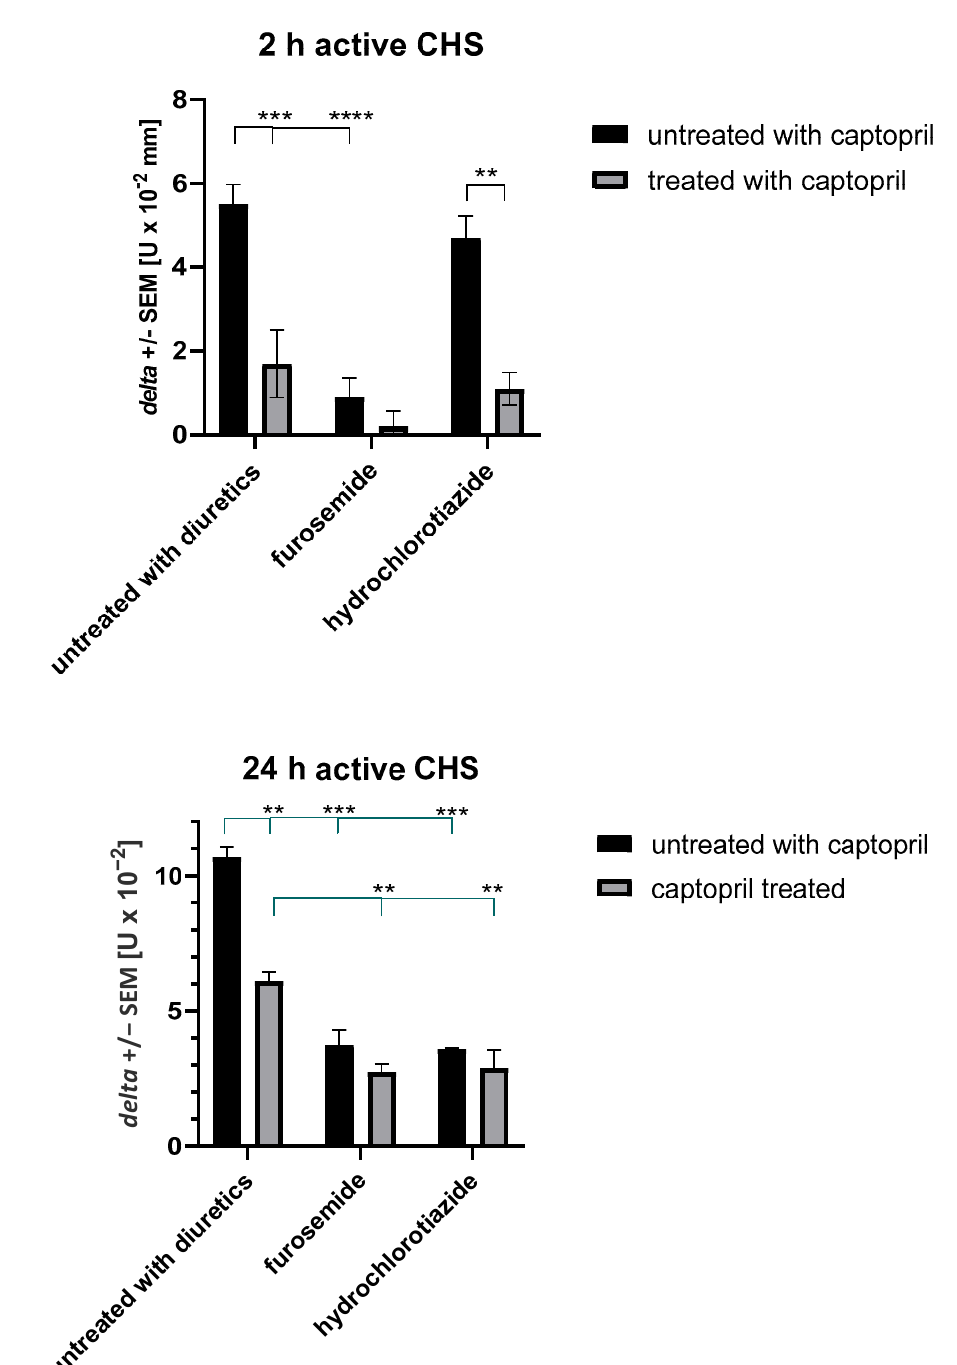
Figure 2. Actively induced CHS reaction in drug-treated mice. Mice were treated intraperitoneally with captopril with or without furosemide or hydrochlorothiazide for eight consecutive days. On the third day, mice were actively sensitized to TNP by topical application of PCL dissolved in a 1:3 mixture of acetone and ethanol on the shaved abdominal skin. Five days later, mice were challenged to elicit CHS ear swelling by topical application of a 0.4% PCL solution in a 1:1 mixture of acetone and olive oil on both sides of both ears. At 2 and 24 h later, the ear swelling was measured with an engineer’s micrometer. The averaged results of ear-thickness increase, after subtracting the ear- thickness increase in non-sensitized but challenged littermate mice, were expressed as delta +/ − standard error of the mean. Two-way ANOVA with Tukey’s post hoc test. ** p < 0.01; *** p < 0.005; **** p < 0.001, n = 4 (in each drug-treated mice test group) + negative control n = 3, N =